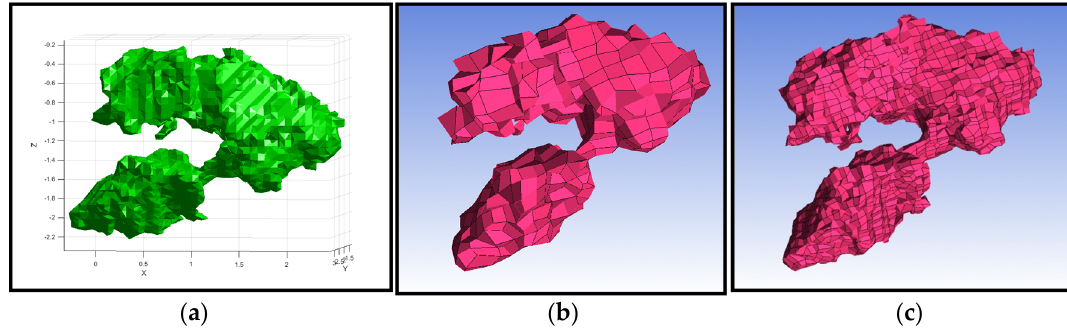
Figure 7. Example of re-meshing of the visual hull output: ( a ) triangular patch representation; ( b ) coarse quadrilateral patch representation; and ( c ) refined quadrilateral patch representation.